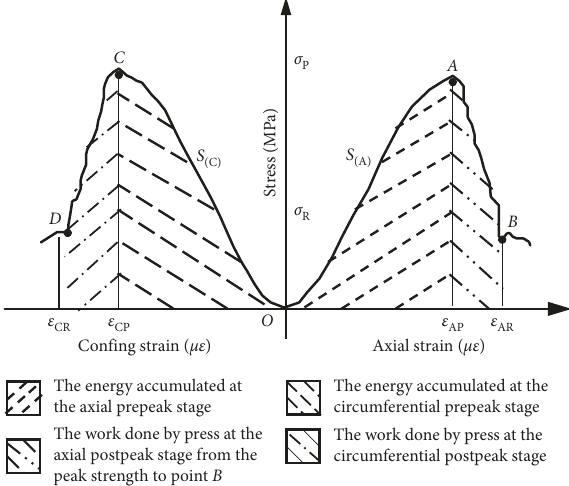
Figure 11: Schematic diagram of slate brittleness